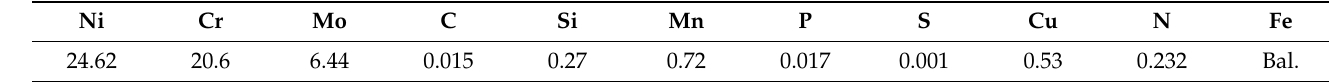
Table 1. Chemical compositions of UNS N08367 (wt%).